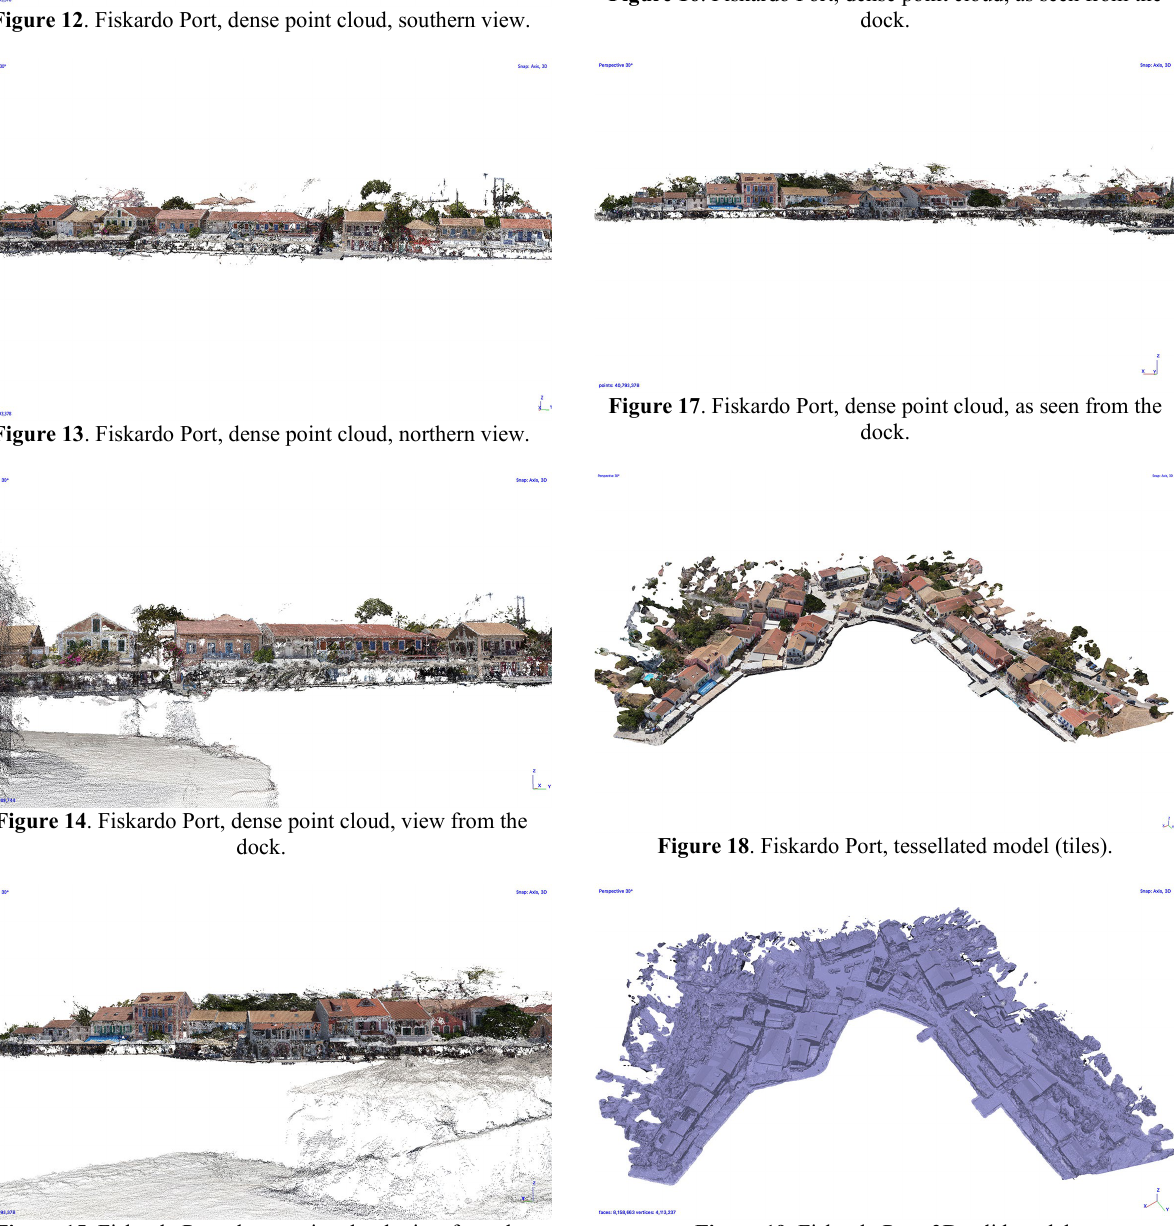
Figure 15 . Fiskardo Port, dense point cloud, view from the dock.